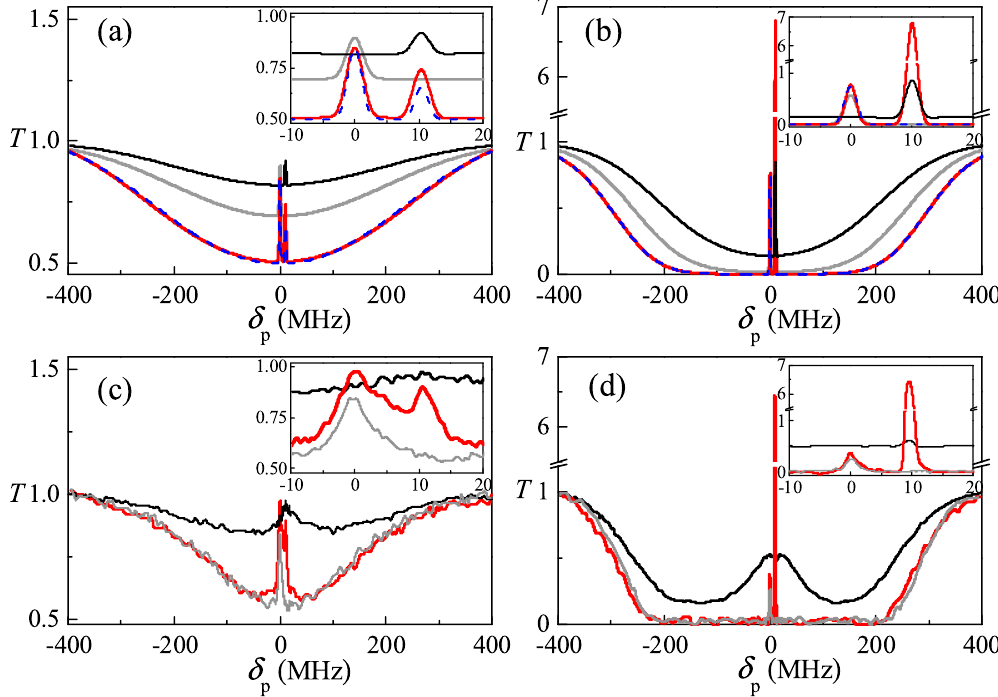
Figure 2. The probe transmission spectra. ( a , b ) For theoretical simulation with ( a ) N = 5 × 10 10 cm − 3 , γ ′ = 20Hz same as those in Fig. 1; ( c , d ) for experiment at ( c ) room temperature, ( d ) T at = 65 °C. Red, gray and black curves for DEIT, hyperfine coherence of EIT when the signal is absent and Zeeman coherence of EIT without the coupling.